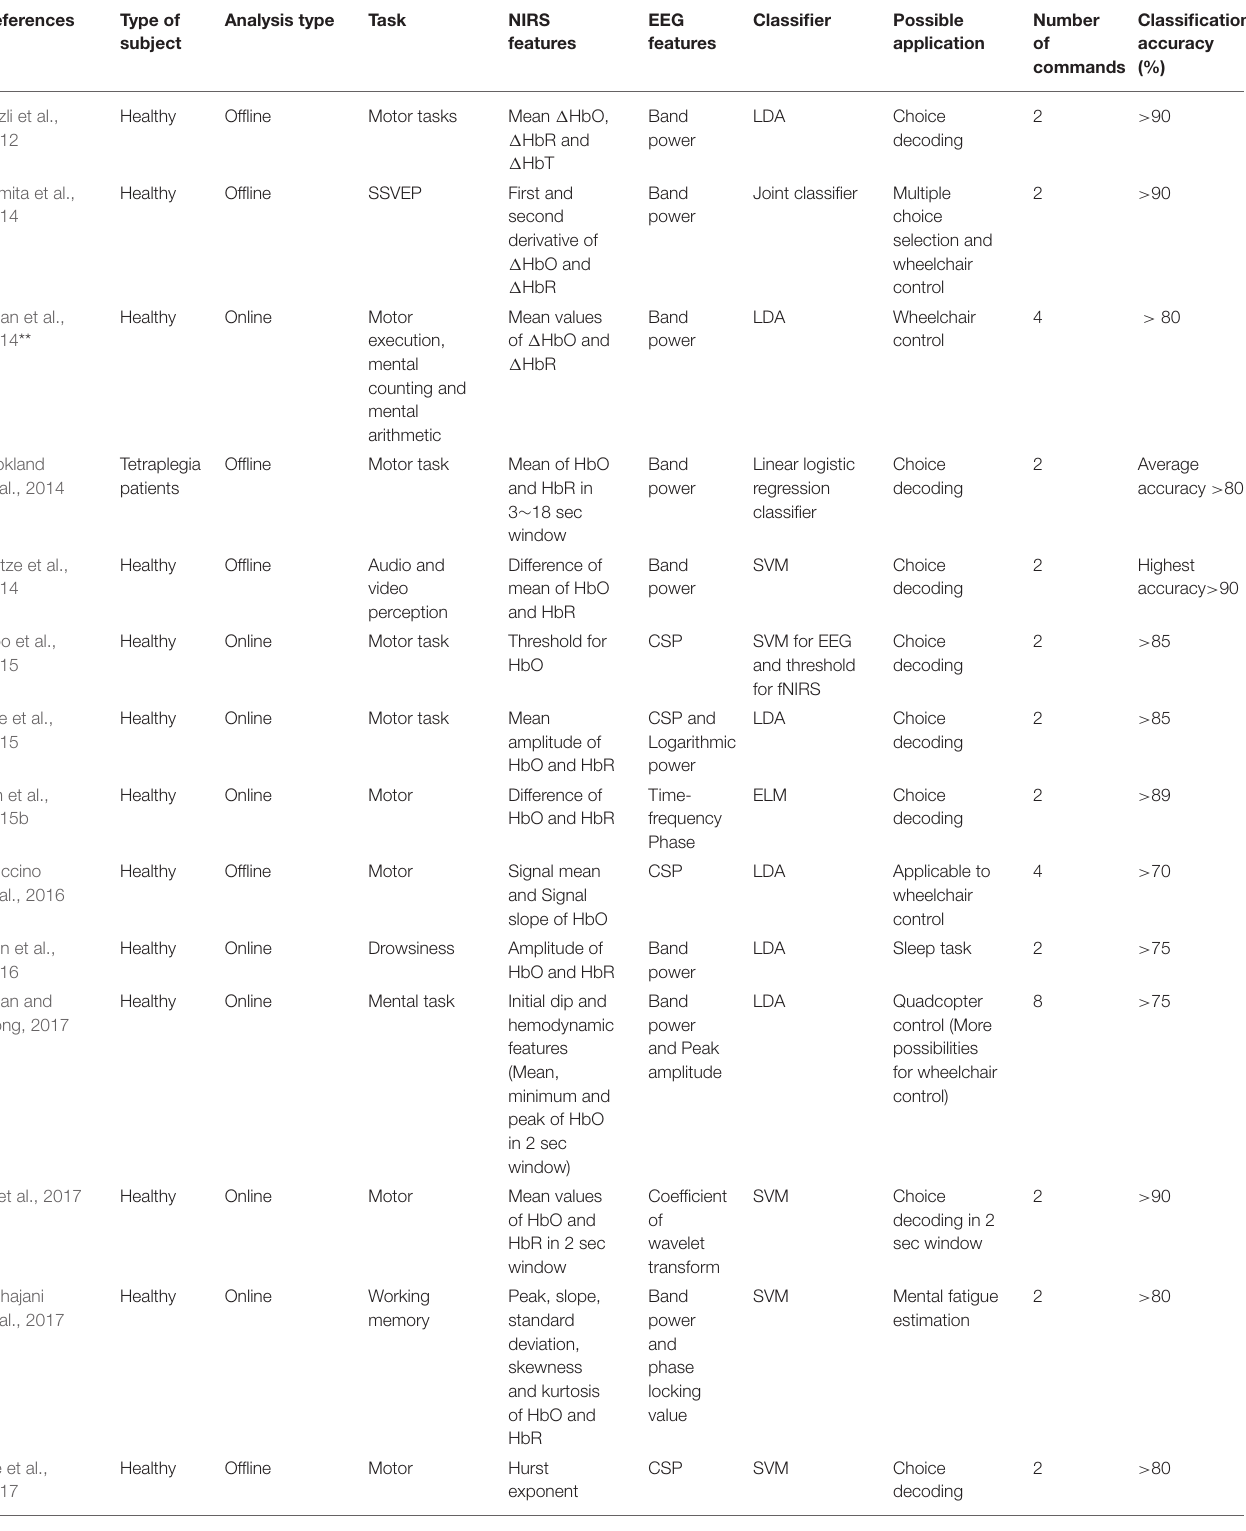
TABLE 4 | Features and classifiers used for hybrid